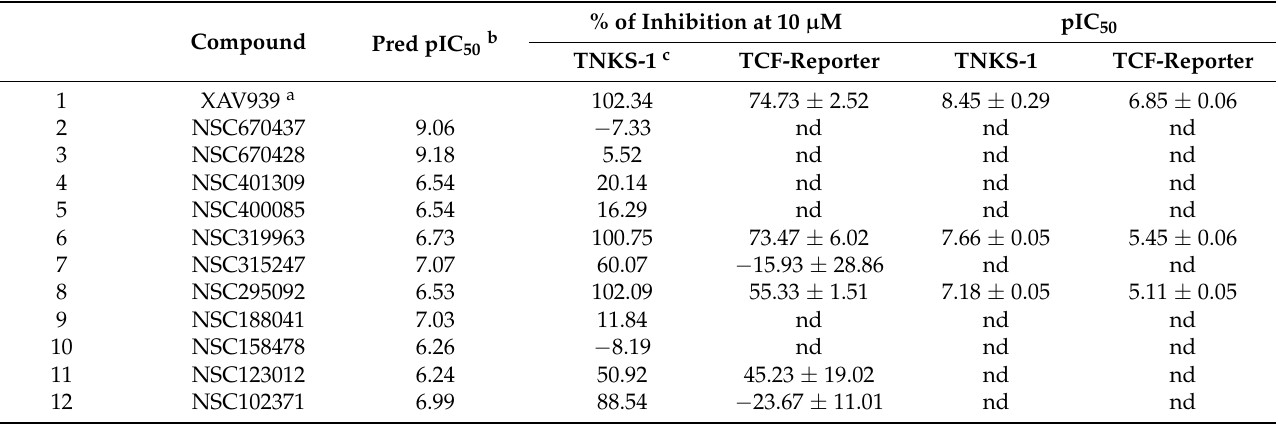
Table 4. Summary of selected compounds and XAV939 for 10 µ M inhibition and pIC 50 in TNKS-1 and TCF-reporter activity